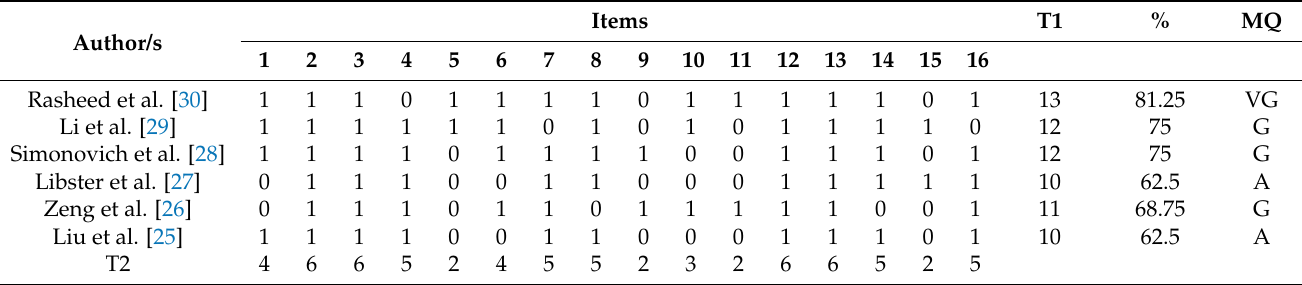
Table 1. Quality assessment of the studies included in the systematic review.